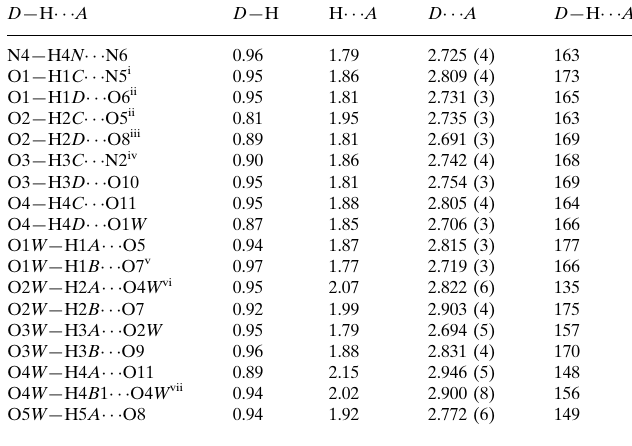
Hydrogen-bond geometry (A˚ , (cid:3) ). D —H (cid:2)(cid:2)(cid:2)